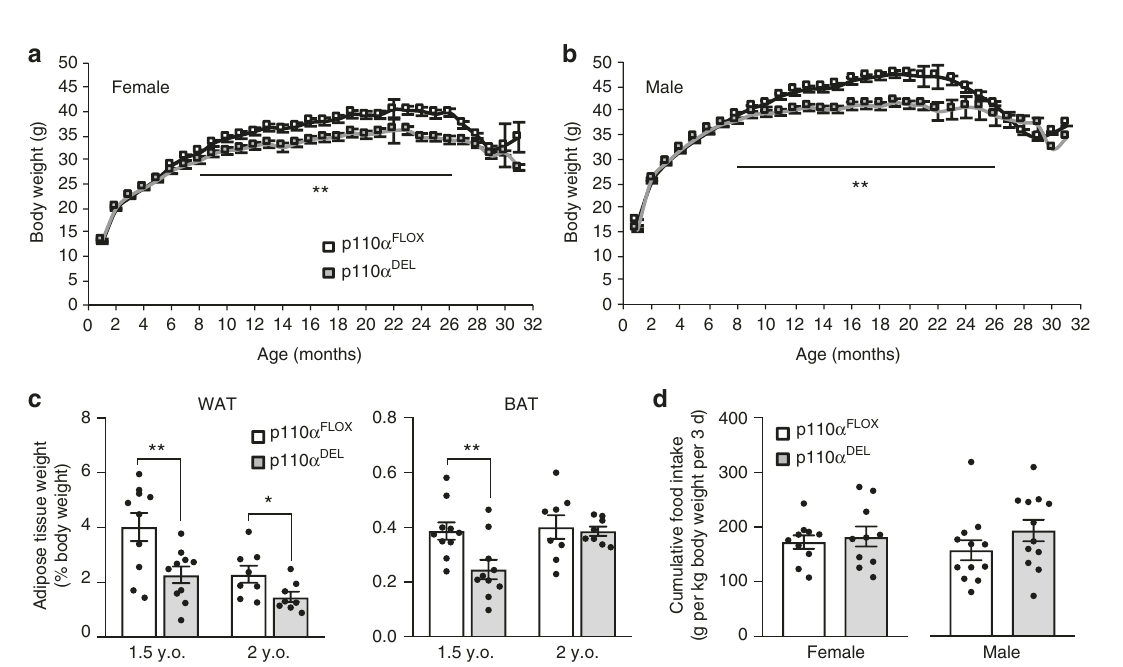
Fig. 7 p110 α DEL mice accumulate less weight with age. a , b Body weight gain over time in female ( a ) and male ( b ) p110 α DEL and p110 α FLOX mice. The average body weight of each group of mice between 8 and 26 months of age were compared by unpaired t test. n = 66 per genotype for male; n = 76 p110 α FLOX and 58 p110 α DEL for female. c Epididymal WAT and interscapular BAT mass of 1.5- and 2-year-old male mice. n = 10 per genotype for WAT; n